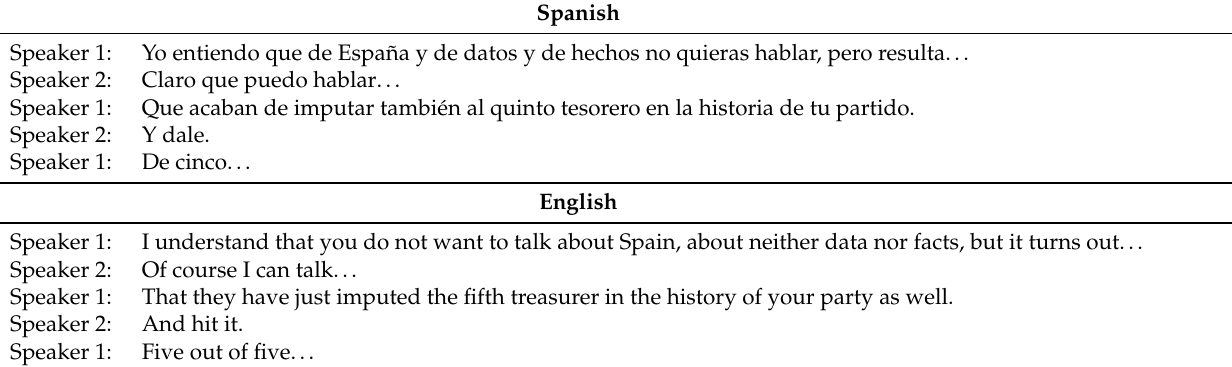
Table 1. Small excerpt extracted from the TV Debates corpus. This is an emotionally rich example of a discussion between two talk-show guests debating politics. The same excerpt is shown in Spanish (the original language) above and in English